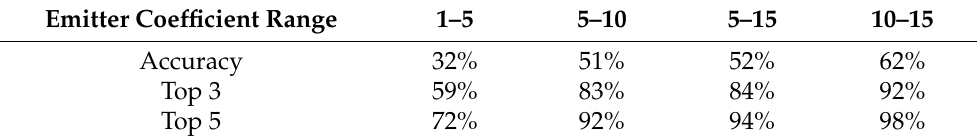
Table 5. Influence of emitter coefficient variation on model accuracy for the Net3 network with a demand variation of ± 2.5% with 500,000